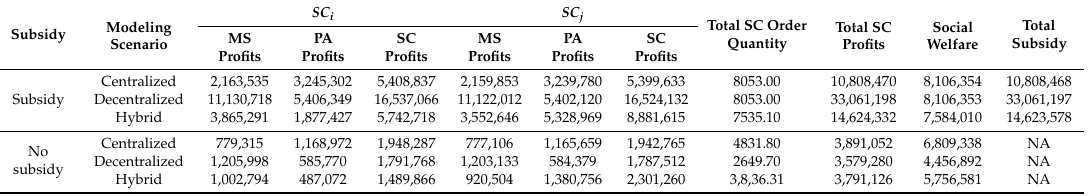
Table 5. Returns to the supply chains and society under different modeling scenarios: subsidy vs. no